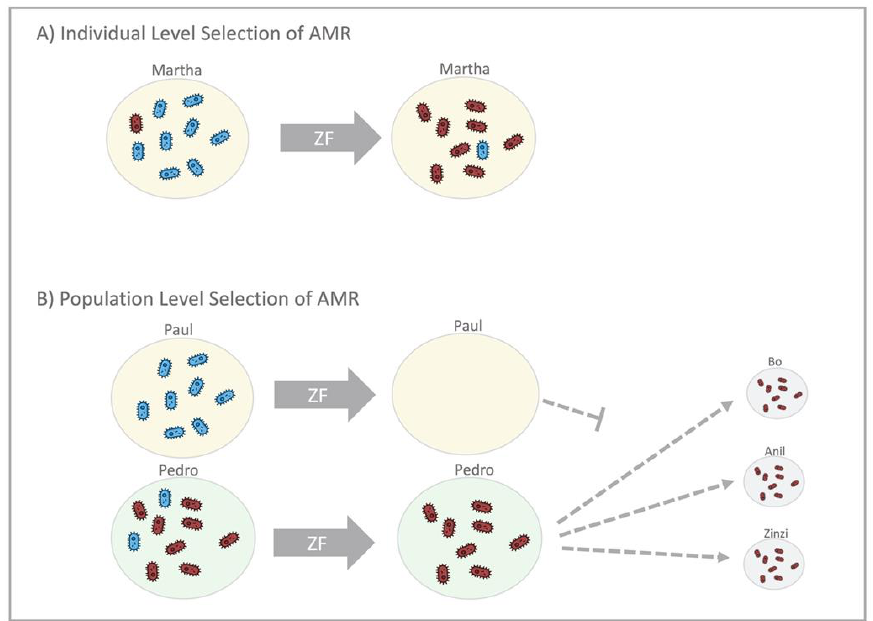
Figure 4. An illustration of individual- and population-level mechanisms that select for antimicrobial resistance (AMR) in commensal Neisseria , using the example of zoliflodacin (ZF). ( A ) In the individual level selection scenario (top), Martha takes ZF, and this eradicates the ZF-susceptible Neisseria (blue bacteria), leaving Martha with predominantly ZF-resistant Neisseria (red bacteria) post-treatment. ( B ) Recent studies have found that commensal Neisseria can be transmitted by kissing. Population-level selection of AMR by widespread use of ZF (bottom) works by eradicating the susceptible Neisseria from Paul and Pedro, leaving only resistant Neisseria to be transmitted by both of them to others.